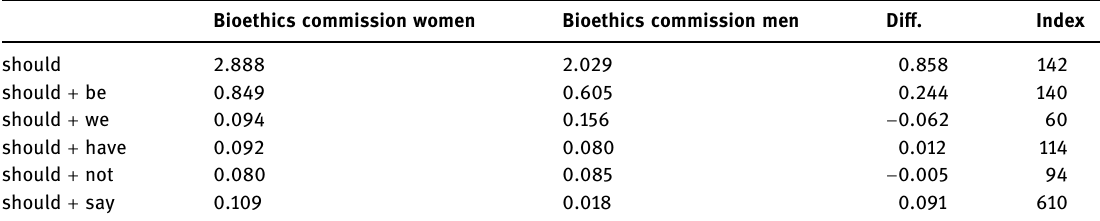
Table 19: Most frequent collocation with “ should, ” as per cent of total tokens ( normalised, n = 1,000